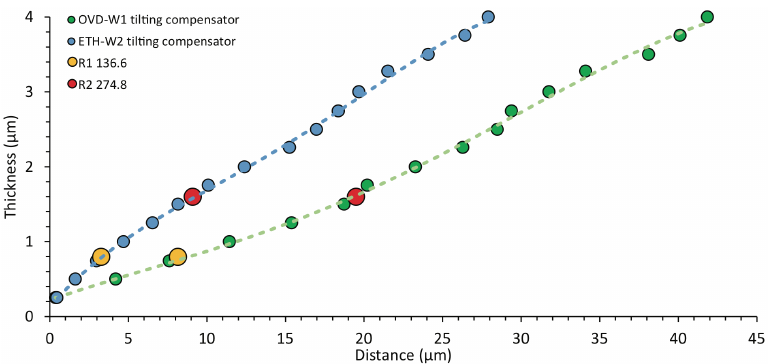
Figure 3. Profile of the calcite wedges OVD-W1 and ETH-W2, as defined by the tilting compensator and the tie points established from the thickness-interference color relationship of the two polymer retarders (R1 and R2).